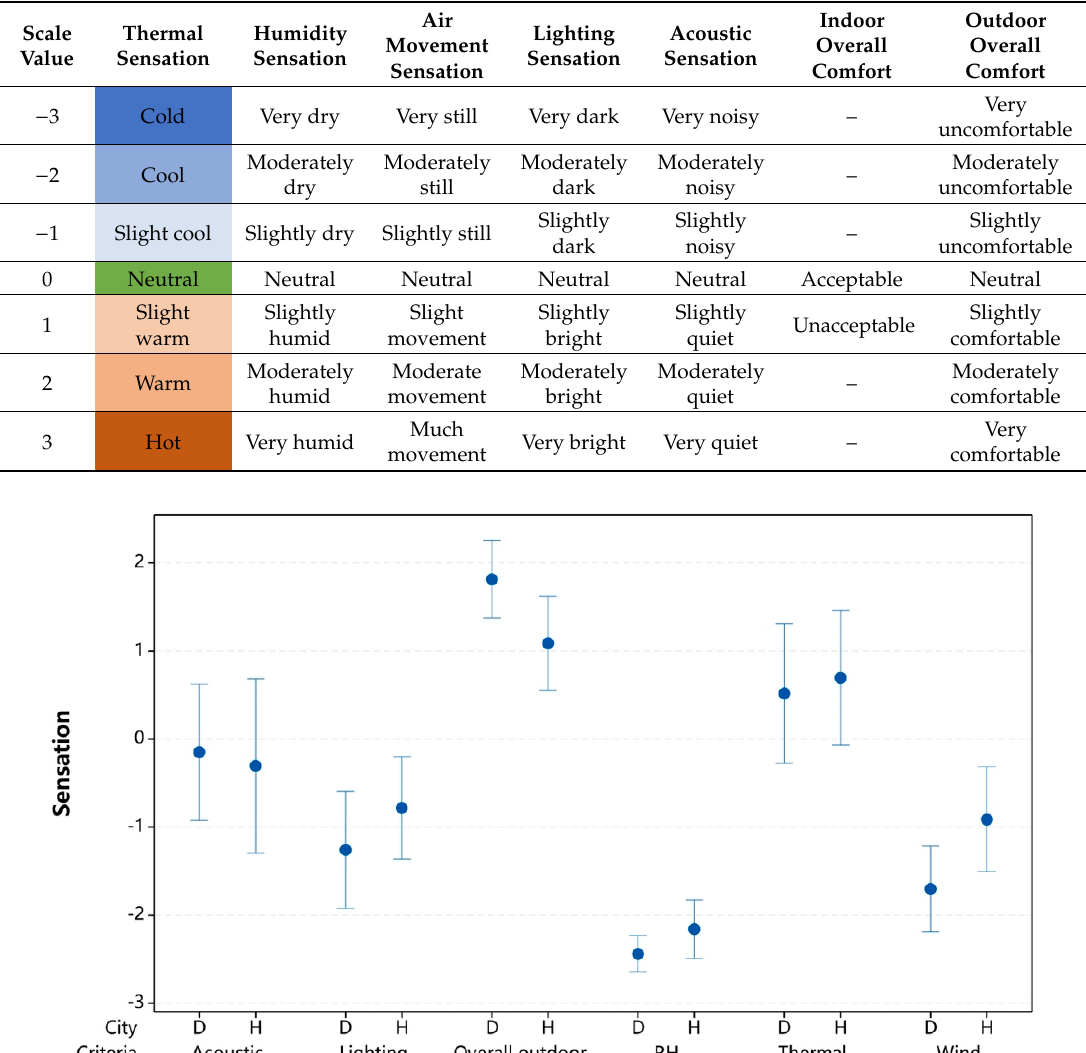
Table 5. Questionnaire scales used to measure sensations and preferences for indoor parameters.